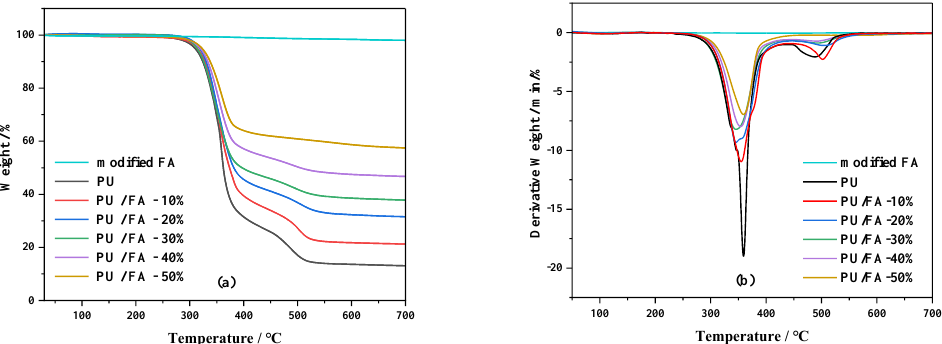
Figure 8. The TG curve ( a ) and DTG curve ( b ) of modified FA, PU, and PU/FA composites. The thermal degradation of PU consisted of two thermal decomposition Table 2. The following thermal stability parameters are calculated by the TG/DTG curve for the PU and PU/FA composites.